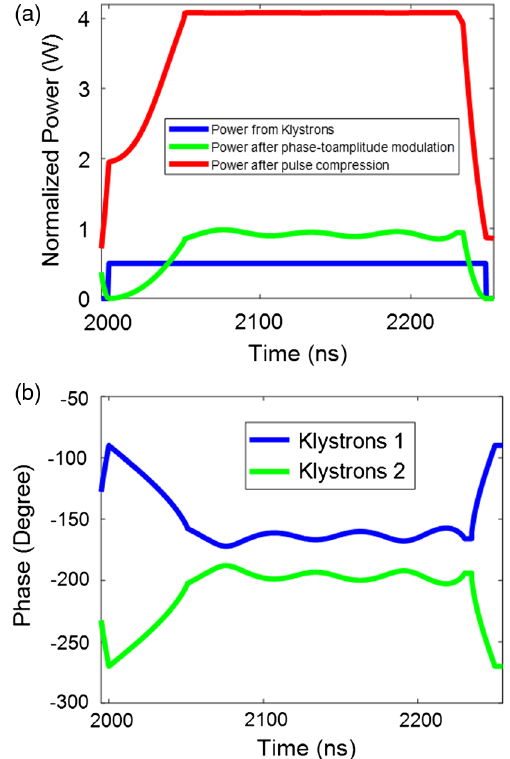
FIG. 8. (a) Waveforms of the input and output pulses after phase-to-amplitude modulation and (b) the modulated phases of the two klystrons. In this case, the compression ratio is 9 and the output pulse length is 250 ns. The unloaded quality factors of the storage and correction cavities are 1 . 77 × 10 5 and 4 . 5 × 10 4 , respectively. The number of the correction cavities is 8.